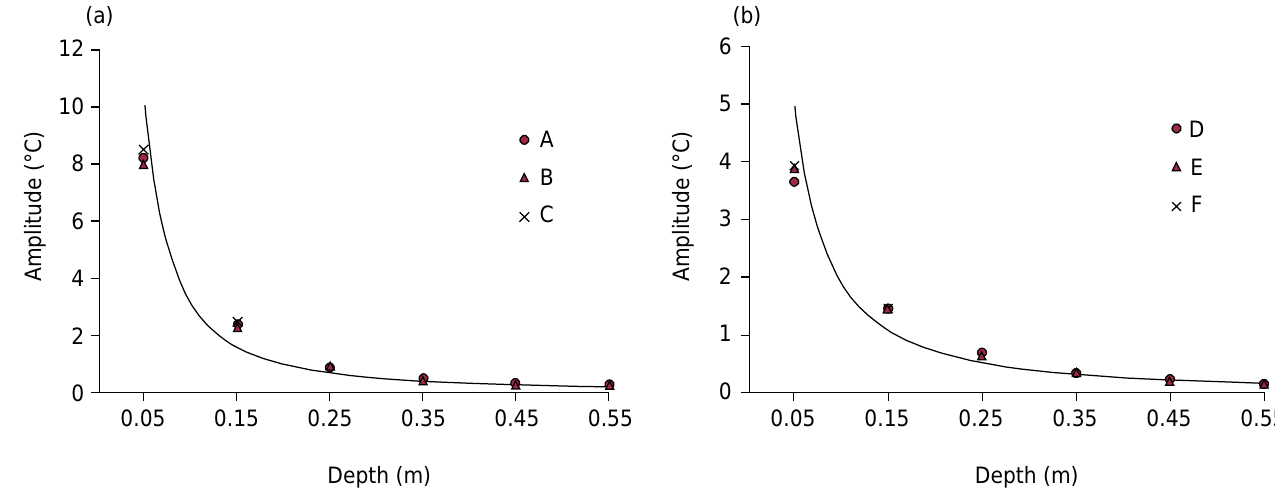
Figure 5. Variation of the thermal wave amplitude with respect to soil depth. The trend line is a potential equation. The error bars are not significant because of its size. a) Letters A, B, and C correspond to April 15, 16, and 17, 2013. b) Letters D, E, and F correspond to August 7, 8, and 9,